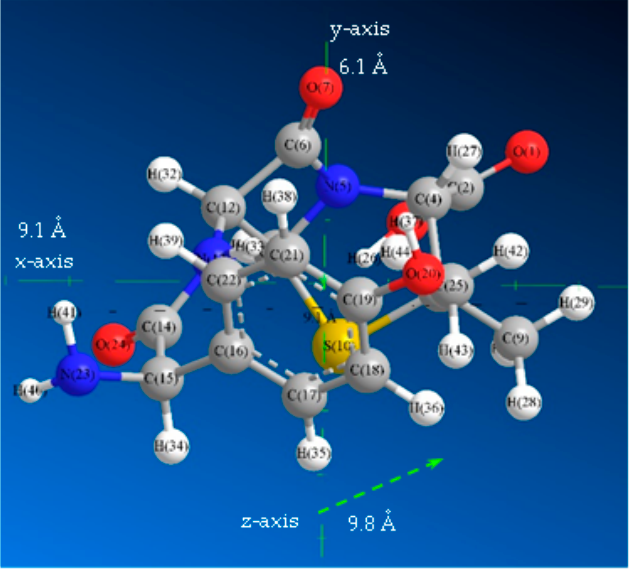
Figure 8. Burst-like drug release from PLA disks prepared from electrospun fibers containing 1.23% Amox.